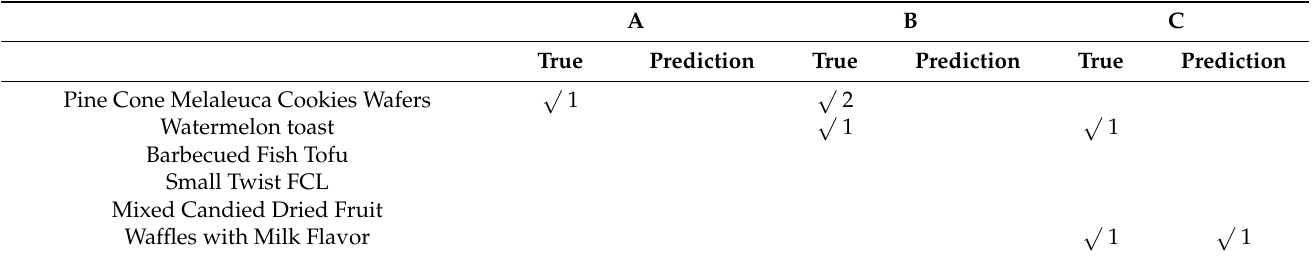
Table 4. Partial results of the empirical